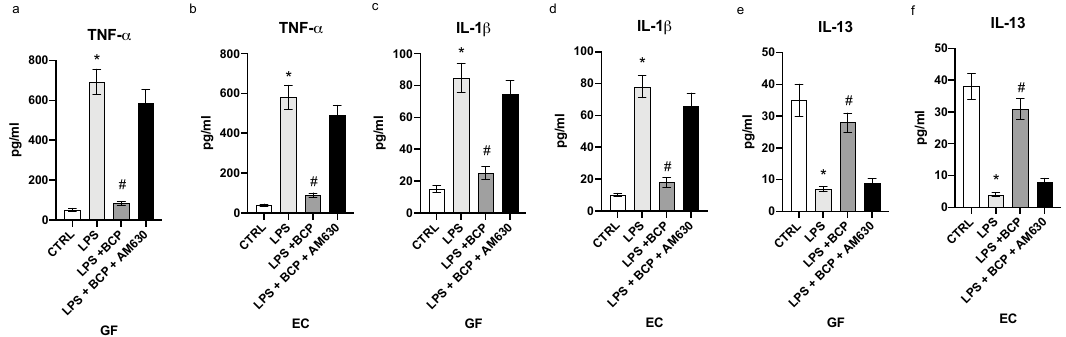
Figure 2. The graphs represent the levels of TNF- α ( a ), IL-1 β ( c ) and IL-10 ( e ) in cell supernatants from GF cells and TNF- α ( b ), IL-1 β ( d ), IL-13 ( f ) levels in cell supernatants from EC cells. Levels of cytokines were evaluated by immunosorbent assay (ELISA). Values are expressed as the means and SD. * p < 0.0001 vs CTRL; # p < 0.0001 vs. LPS.